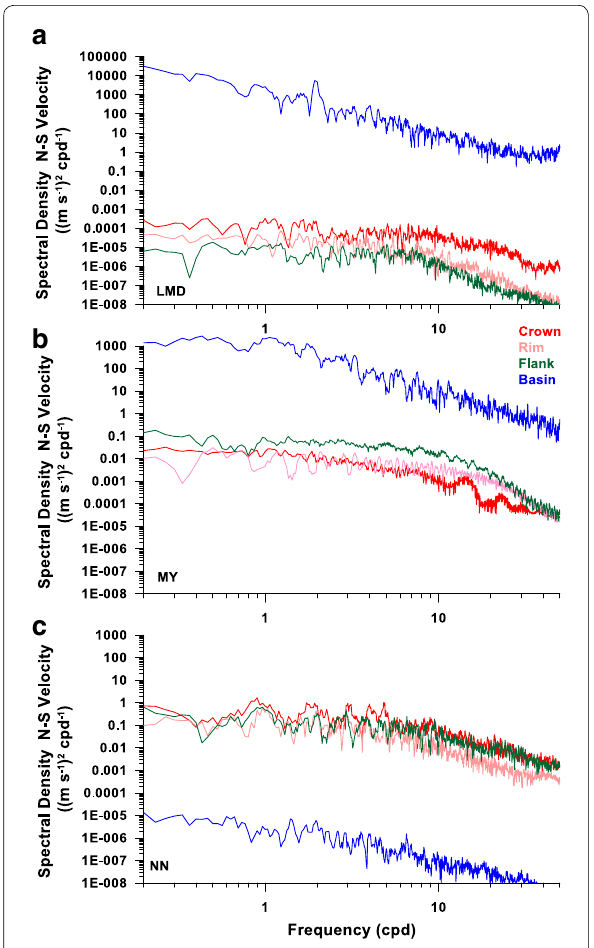
Fig. 9 Spectra of the benthic (level 5) vertical temperature diffusivities at four locations over the guyot: crown (C) (red), rim (R2) (pink), flank (F2) (green), and basin (B2) (blue) from simulations using the a LMD, b MY, and c NN vertical mixing parameterizations. Notice that the scale goes 2 orders of magnitude higher in